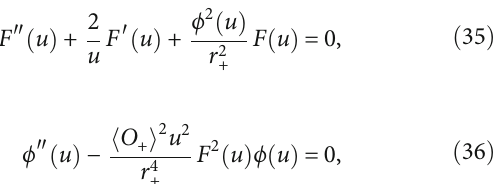
1 obtained analytically and numerically,